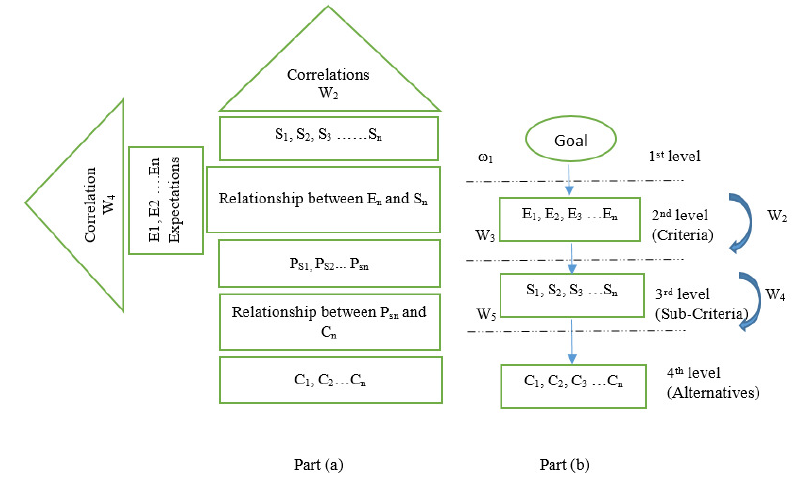
Fig. 1. A two stage QFD model and its representative ANP